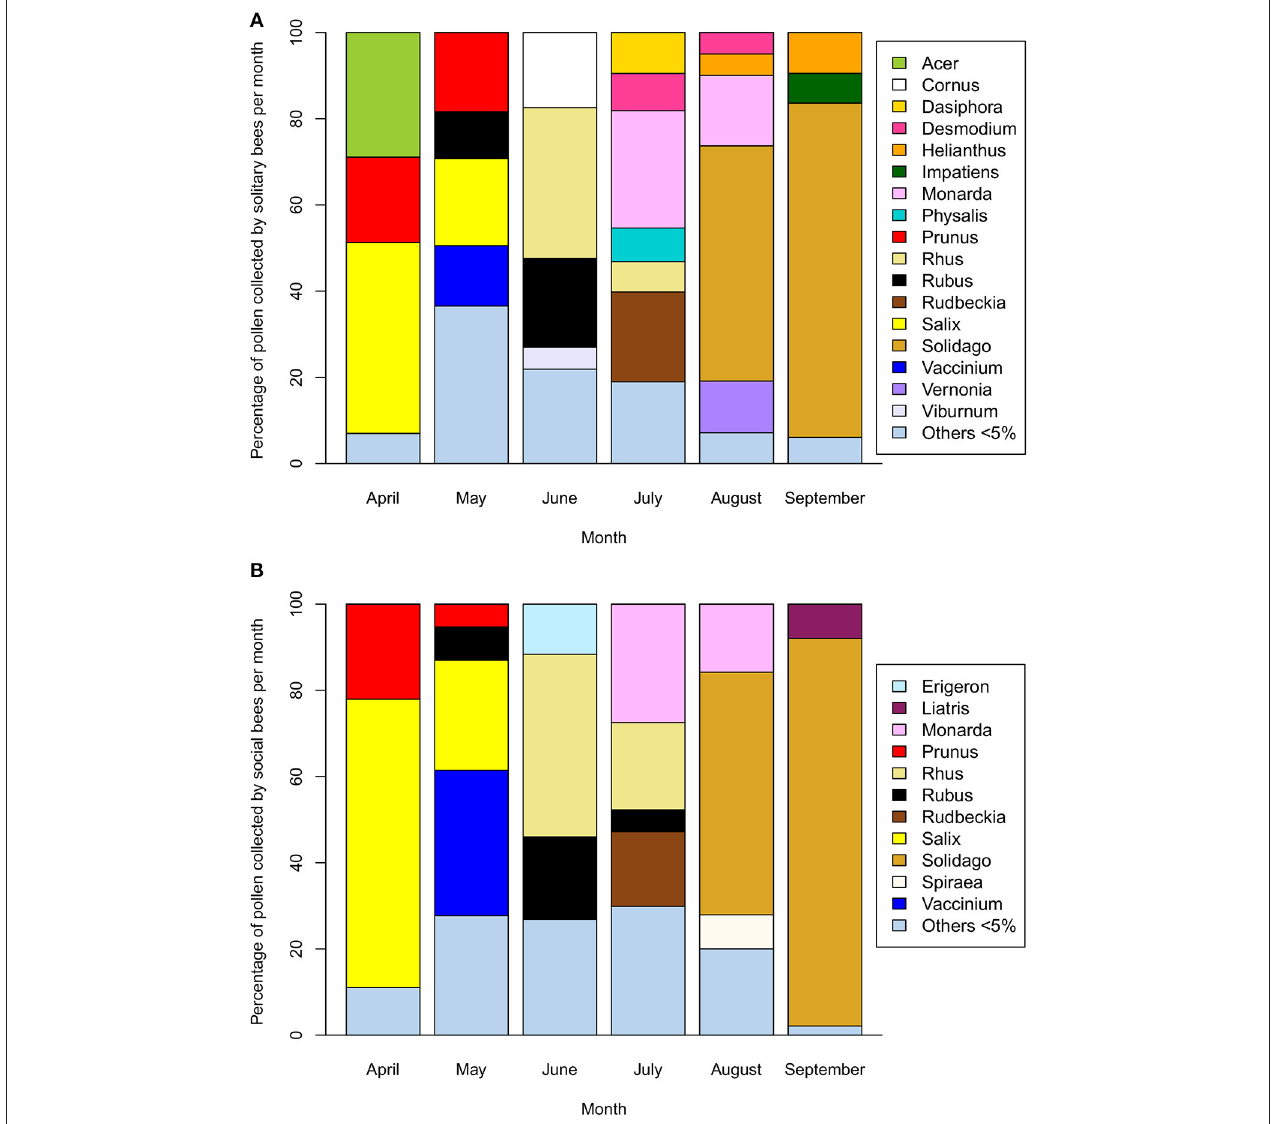
FIGURE 3 | Percentage of pollen collected from native plant genera by (A) wild solitary bee species ( n = 152) and (B) wild social bee species ( n = 29) in Michigan across the April-September flowering season (2006–2018). Plant species collected at < 5% of the average monthly volume are included as “Others”.